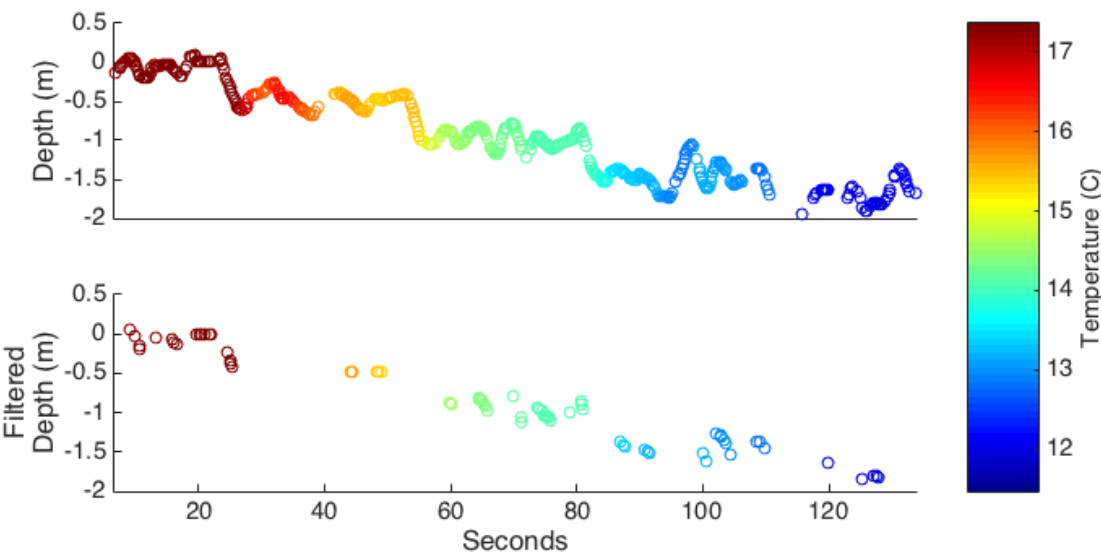
Figure 4. The filtering method removes data when temperature and depth change